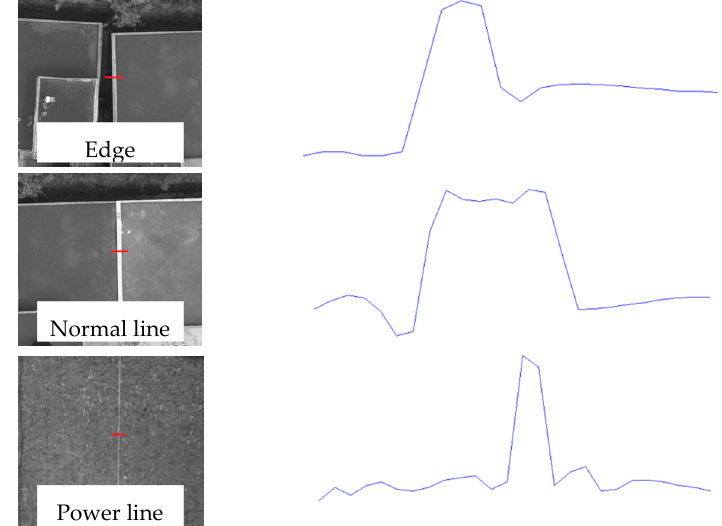
Figure 6. Typical features of power lines that differ from other objects. Blue curves are the gray value profiles of the red segments in the images on the left.